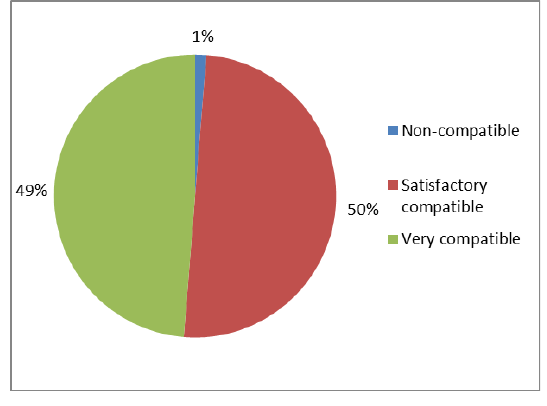
Fig. 3. Perceived Pair